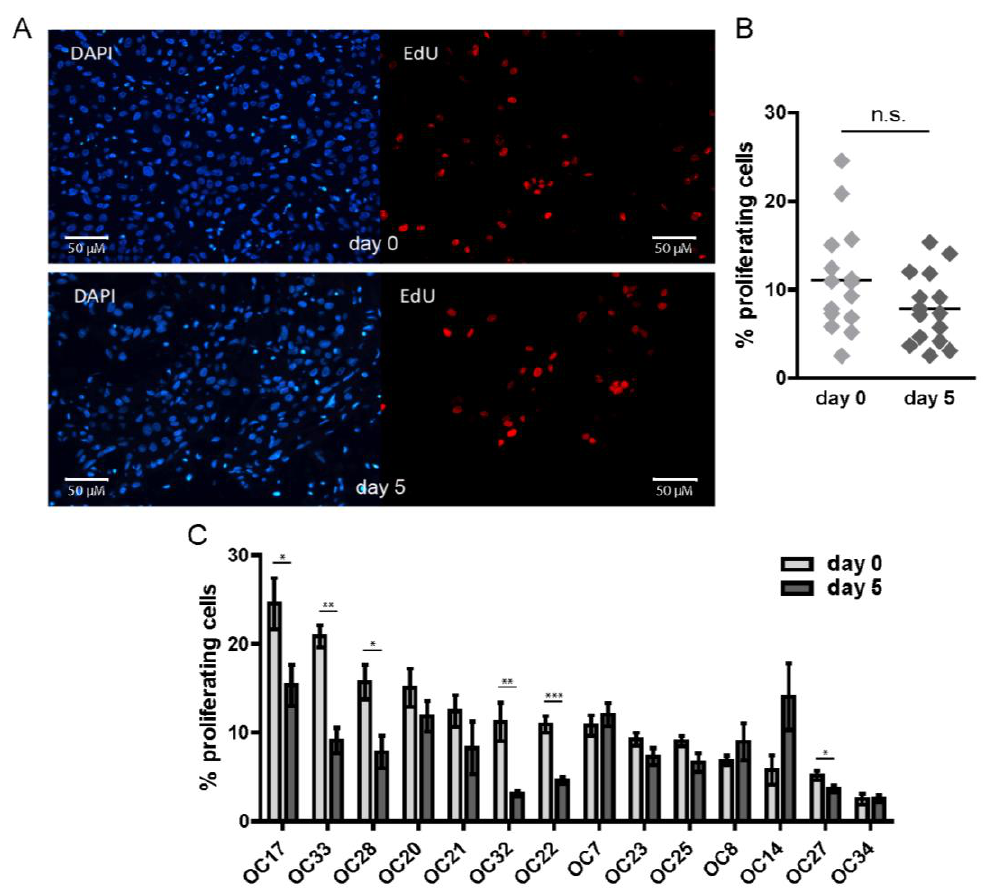
Figure 2. HNSCC tumor cells maintain proliferation during five days of culture. ( A ) Representative microscopy images of EdU staining at day 0 and day 5 of the ex vivo culture. ( B ) Quantification of the EdU-positive cells at day 0 and day 5 of the ex vivo culture. Each point represents the mean of ≥3 FoV per sample, and the mean across all day 0 or day 5 samples is indicated with a horizontal line. ( C ) Change in the % of EdU-positive cells upon five days of culture. Each graph bar represents the mean of ≥3 FoV and error bars represent SEM. A t-test was used to determine significance. n.s. = non-significant; * p < 0.05; ** p < 0.01; *** p < 0.001.